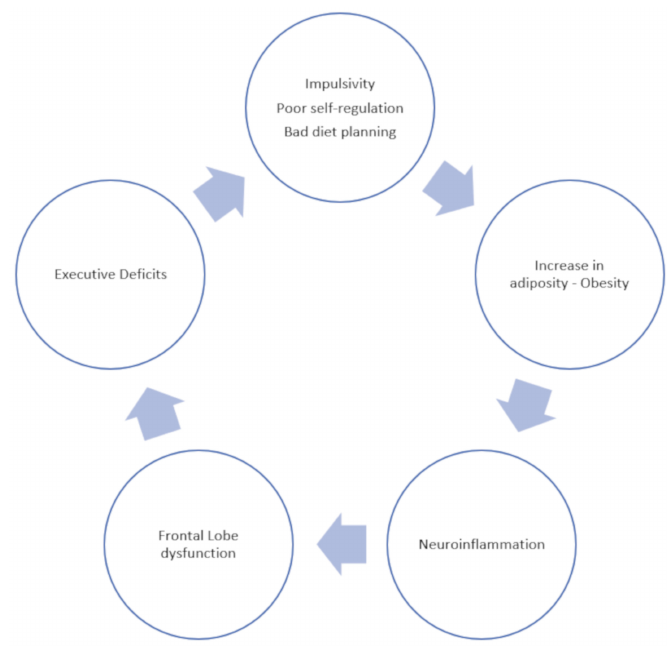
Figure 4. Proposed explanatory model for the relationship between obesity and executive functioning